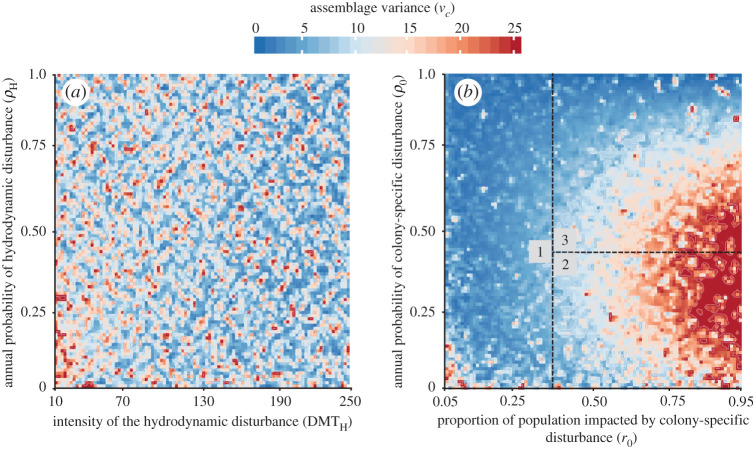
Heat map of variance in assemblage structure, summarizing the results of 100 000 simulations across ranges of two disturbance parameters. The same data are presented in panels (a) and (b), differing solely in the disturbance parameters across which the variance data are presented, across two parameters describing hydrodynamic disturbance and colony-specific disturbance, respectively. (a) Estimated temporal variance (vc) of the coral communities as a function of the intensity of the hydrodynamic disturbance (DMTH) and the annual probability of a hydrodynamic disturbance (ρH). (b) Estimated temporal variance (vc) of the coral communities as a function of the proportion of population impacted by colony-specific disturbance (r0) and the annual probability of colony-specific disturbance event (ρ0). Patterning in the variance is related to two major splits in the regression tree (figure 1). The first split in the regression tree can be visualized as zone 1 (depicted with the number ‘1’ in panel b), defined by the condition r0 < 0.36, which contains simulations leading to stereotypical assemblages 10–18 in figure 1. Within the range r0 ≥ 0.36, the second split maps onto the variance; zone 2 (ρ0 < 0.44) contains simulations leading to stereotypical assemblages 5–9 in figure 1 and the remainder in zone 3 contains simulations leading to stereotypical assemblages 1–4 in figure 1.